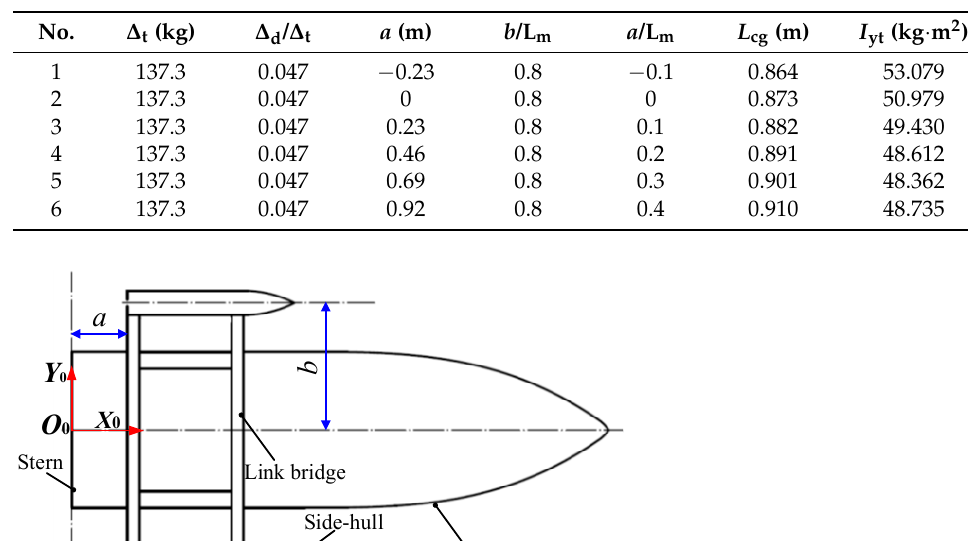
Figure 26. Waterline surface comparisons of the two navigation states when L cg /L m = 0.35. Table 8. Six longitudinal locations of side-hulls in the TFS.